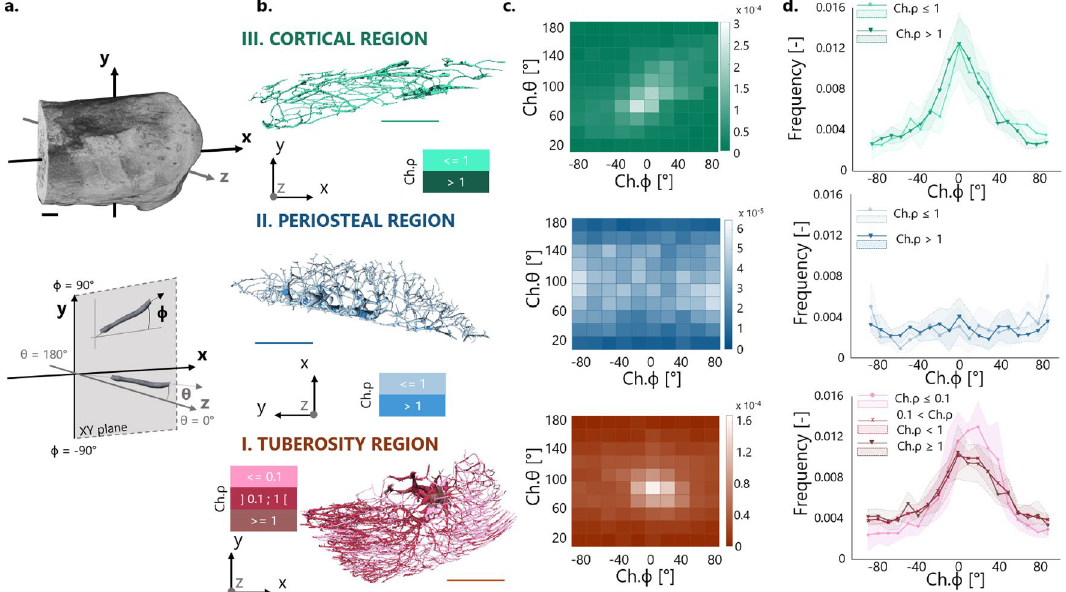
Figure 6. Three-dimensional local analysis of the subchondral channel network at the three sites of interest based on the high-resolution micro-CT scans. ( a ) Representation of the spherical coordinate system with the azimuthal ( ) and polar (θ) angle defining the orientation of the channels. ( b ) Illustration of extracted channel network skeletonized to resolve individual channels, which are classified and colored according to the ϕ aspect ratio as thick, slender and extremely slender. ( c ) Representative two-dimensional heat maps of channel orientation, revealing a specific pattern for each region. Dataset relative to one animal and data normalized to unit volume. ( d ) Frequency distributions (normalized to unit area) of the azimuthal angle (Ch. the orientation of the channel in the XY sagittal plane for the entire dataset. Channels are classified according to the aspect ratio as thick, slender and extremely slender. Data reported as mean value (thick lines) with standard deviation (shaded areas). Scale bars: 500